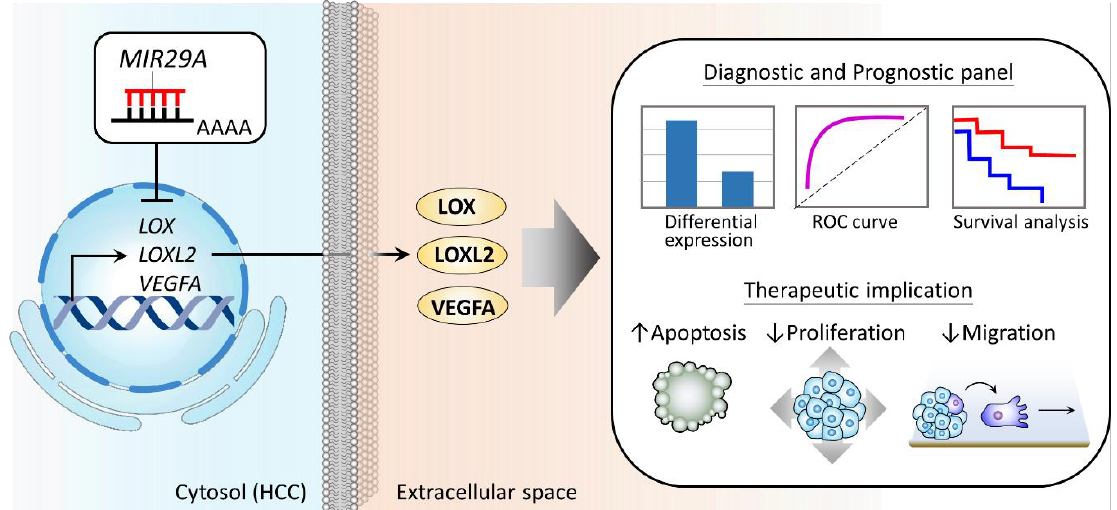
Figure 7. Proposed model illustrating the diagnostic and prognostic value of MIR29A and its biological role in suppressing HCC metastatic behaviors. MIR29A , LOX , LOXL2 , and VEGFA serves as a panel of diagnostic and prognostic factors. Mechanistically, elevated MIR29A acts toward the downregulation of LOX , LOXL2 , and VEGFA , leading to an impeded metastatic behavior by inducing cell apoptosis and suppressing proliferation and migration.